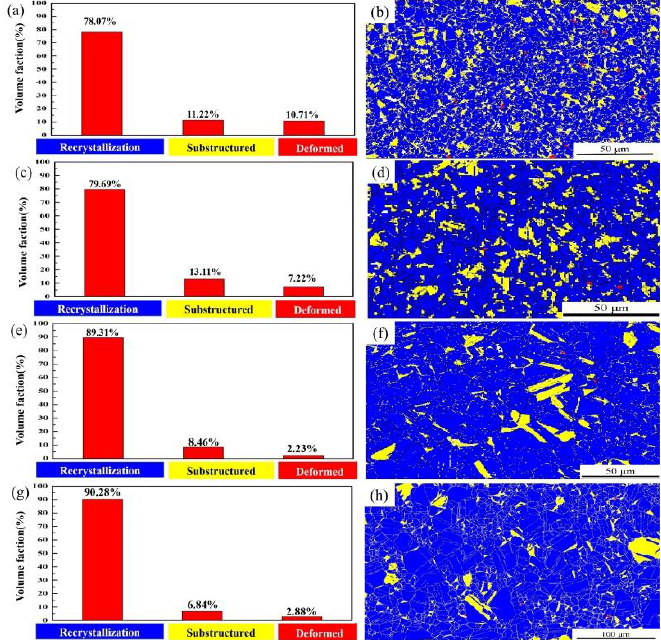
Figure 6. Distribution of recrystallized fraction and recrystallization maps of annealed Cu-2.7Be samples: ( a ) and ( b ) 650 °C/15 min, ( c ) and ( d ) 650 °C/1 h, ( e ) and ( f ) 770 °C/15 min, ( g ) and ( h ) 770 °C/1 h.